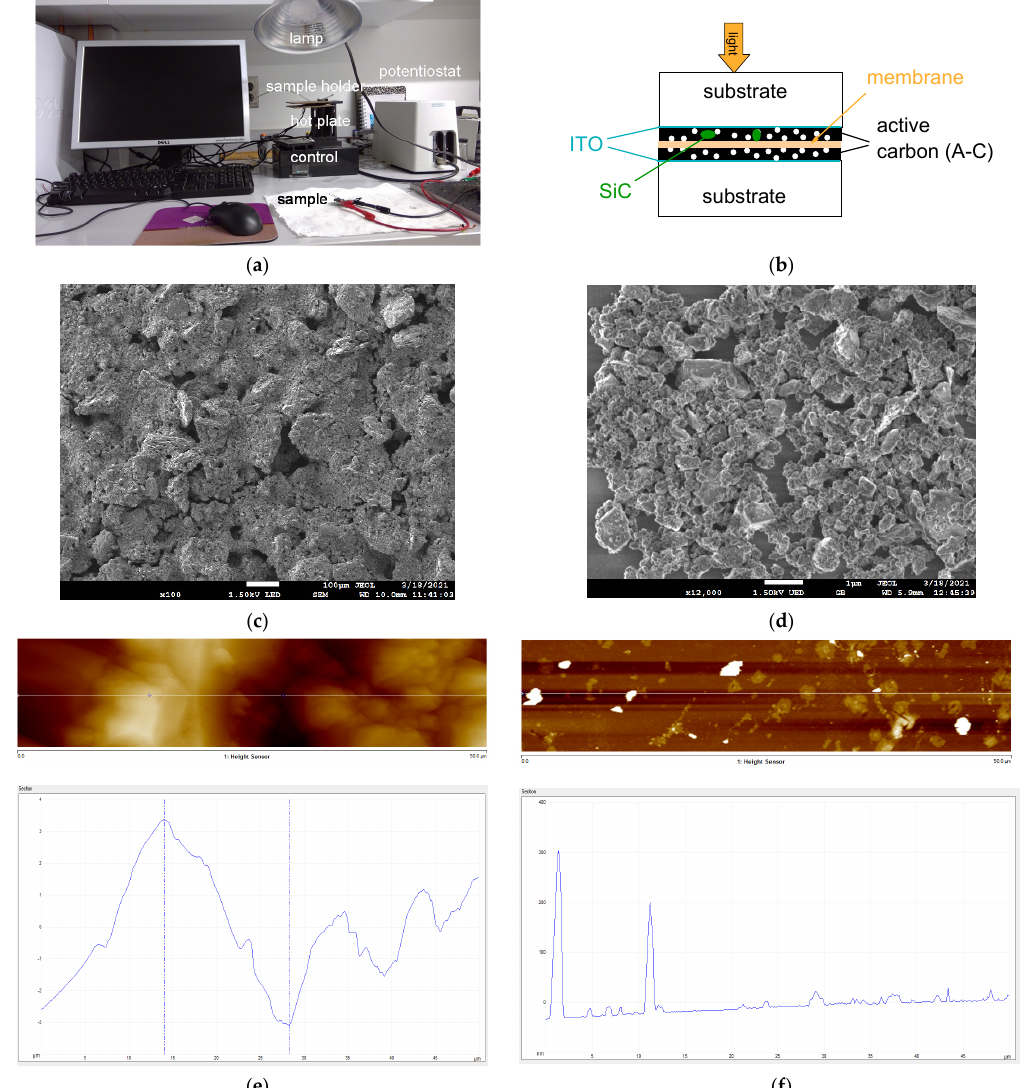
Figure 1. ( a ) Picture of the experimental set-up. ( b ) Schematics of the sample: TS80 is the hydrophilic membrane; ITO: indium-tin-oxide; ( c ) SEM picture of a film composed of A-C with a PMMA binder. The bar is 100 µ m. ( d ) SEM picture of sub-micron SiC particles on glass. The bar is 1 µ m. ( e ) AFM profile of a film made of A-C with a PMMA binder. ( f ) AFM profile of SiC particles on